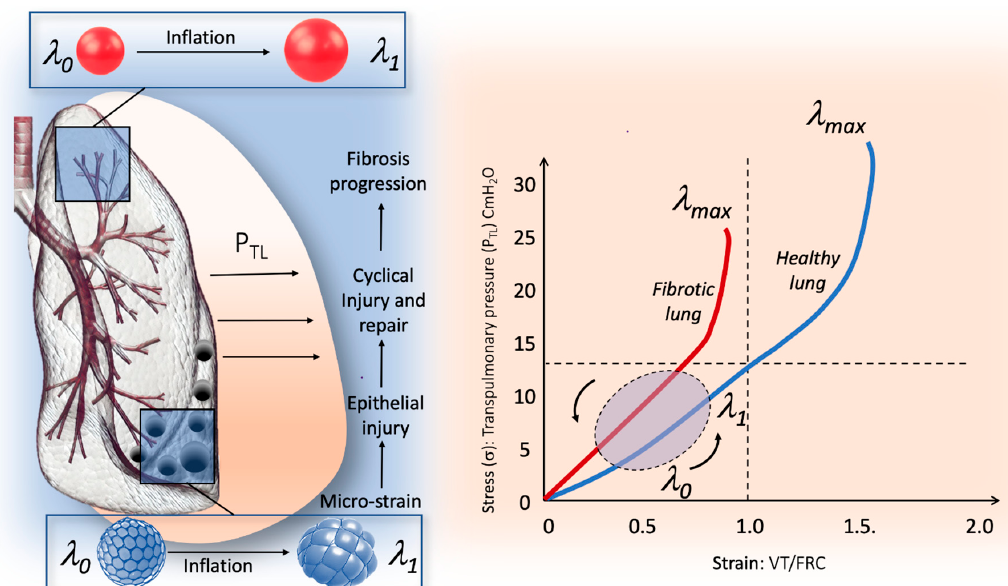
Figure 1. Relationship between micro-strain and global stress–strain curve in human lung. The right part of the figure illustrates the stress–strain curve in the healthy lung (blue line) and in the fibrotic lung (red line). In the fibrotic lung, the stress–strain is steeper compared to healthy lung, which is due to the higher specific elastance (the slope of the curve in its linear portion); therefore, the transition from elastic to plastic behavior is achieved for lower stress–strain values. The left part of the figure illustrates the behaviors of the IPF lung during inflation, from l0, which correspond to the elastic equilibrium of the respiratory system (i.e., functional residual capacity) to 11, which corresponds to the end of tidal volume. The fibrotic lung is made up of a patchwork of areas of different elasticity predominantly in the basal and subpleural zone, in which areas of dense fibrosis and areas of spared lung tissue are contiguous. During inflation, areas of the lung with normal elasticity surrounded by inelastic tissue protrude outside the lung surface exhibiting squishy ball-like behavior. Thus, in these areas, the global lung strain does not represent the micro-strain. The traction exerted by the non-physiological cyclic micro-strain could result in epithelial injury and finally in fibrosis progression.